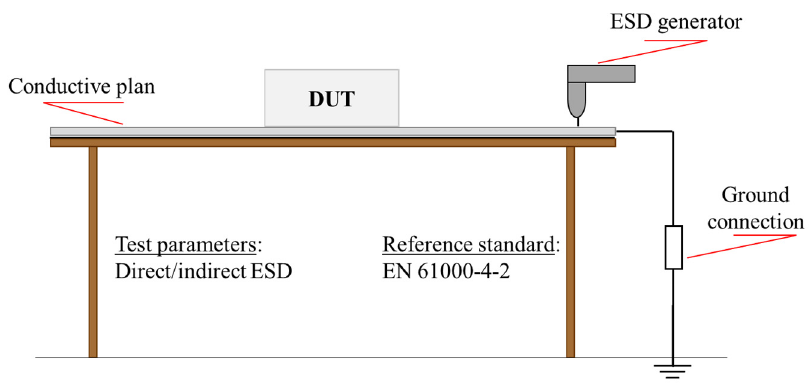
Figure 5. Electrostatic discharge (ESD) test set-up.